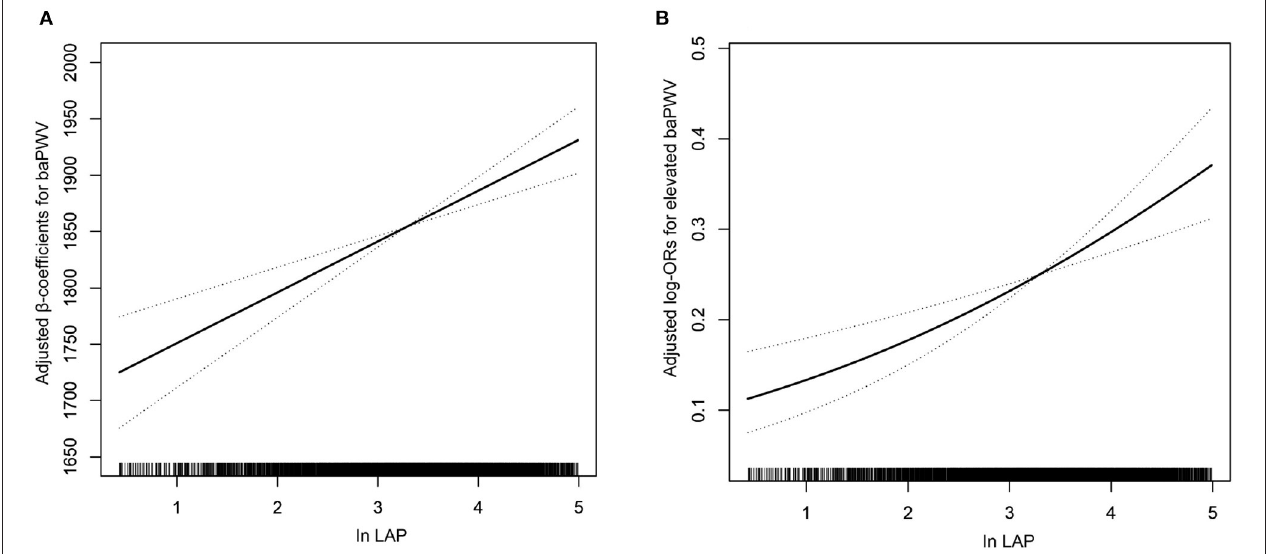
FIGURE 1 | Association of the lipid accumulation product (LAP) index with (A) brachial-ankle pulse wave velocity (baPWV) and (B) elevated baPWV. A linear association between the LAP index and baPWV and elevated baPWV was found ( p < 0.05). The solid line and dashed line represent the estimated values and their corresponding 95% CI. Adjustment factors included age, sex, body mass index (BMI), systolic blood pressure (SBP), diastolic blood pressure (DBP), pulse rate, pulse pressure, smoking status, drinking status, fasting blood glucose (FBG), total cholesterol (TC), high-density lipoprotein (HDL), low-density lipoprotein cholesterol (LDL-C), homocysteine (Hcy), uric acid, estimated glomerular filtration rate (eGFR), diabetes mellitus, antihypertensive drugs, antiplatelet drugs, the types of antihypertensive drugs, duration of hypertension, and glucose-lowering